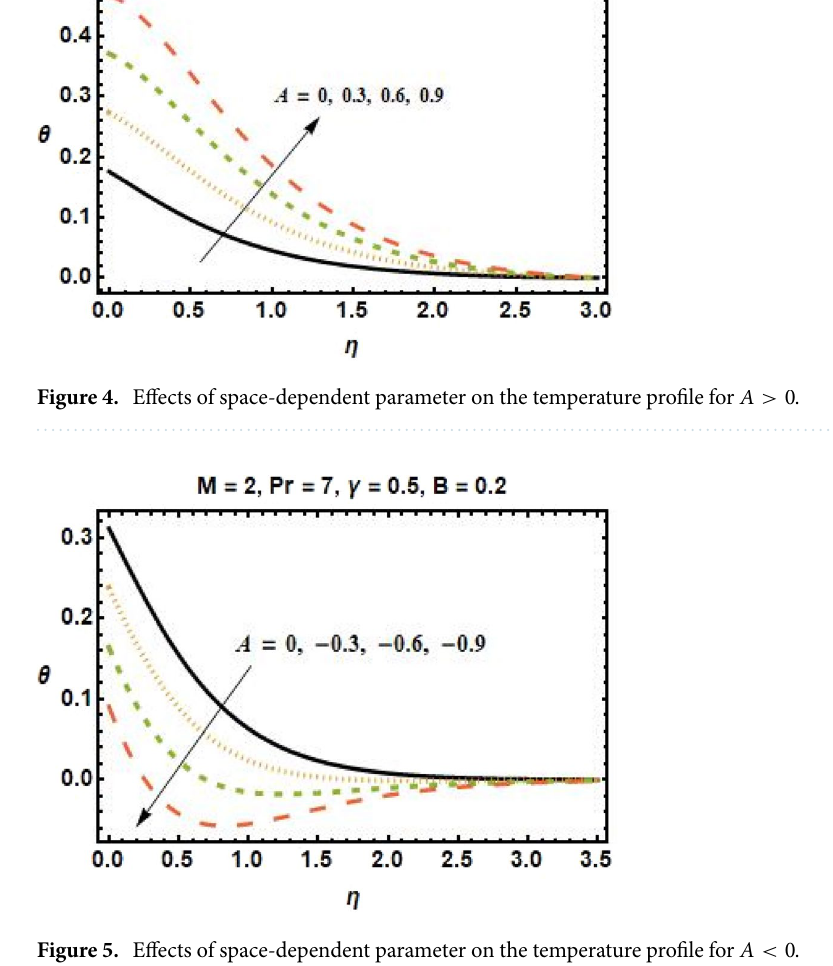
Figure 5. Effects of space-dependent parameter on the temperature profile for A < 0 .